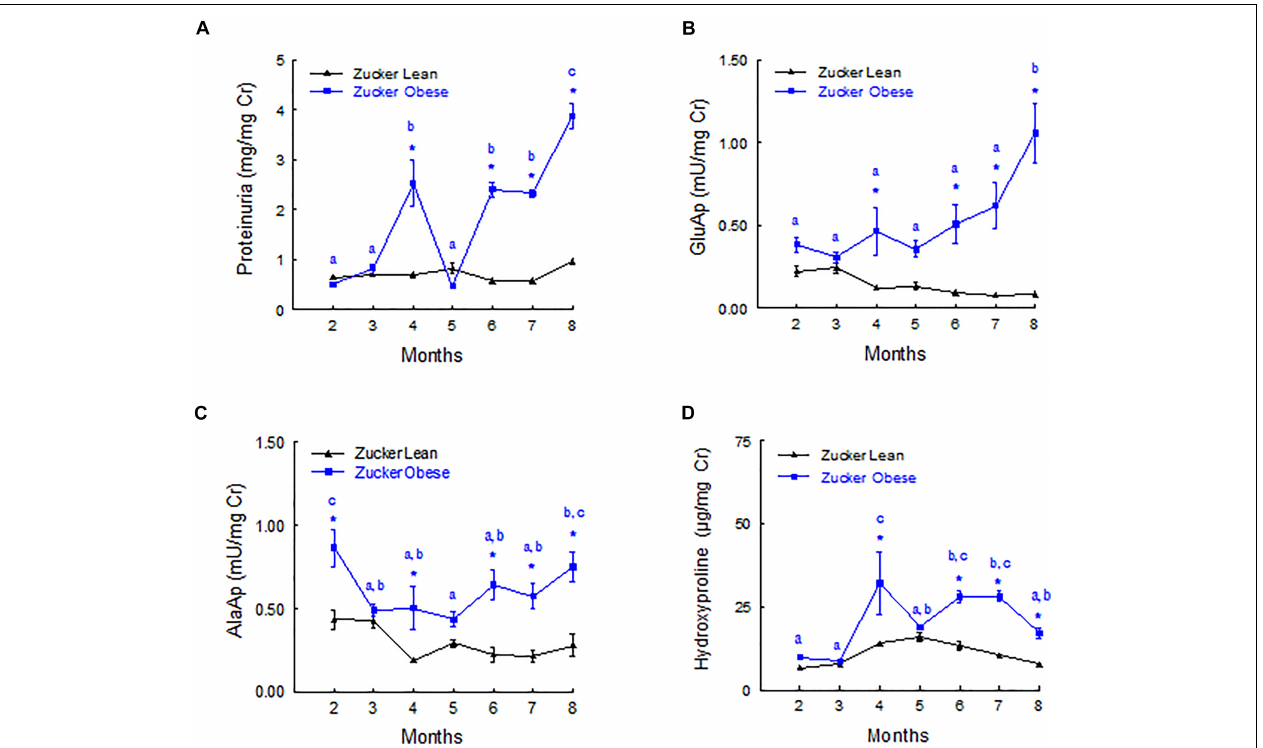
FIGURE 2 | Time course of urinary biomarkers normalized by creatinine excretion. Proteinuria (A) , GluAP (B) , AlaAP (C) , and hydroxyproline (D) in male Zucker lean and obese rats. Data are means ± SEM. ∗ p < 0.05 compared with Zucker lean rats ( n = 10, each group). Means with the same letter (a, b, or c) indicates sets of means within there are no significant difference at p <